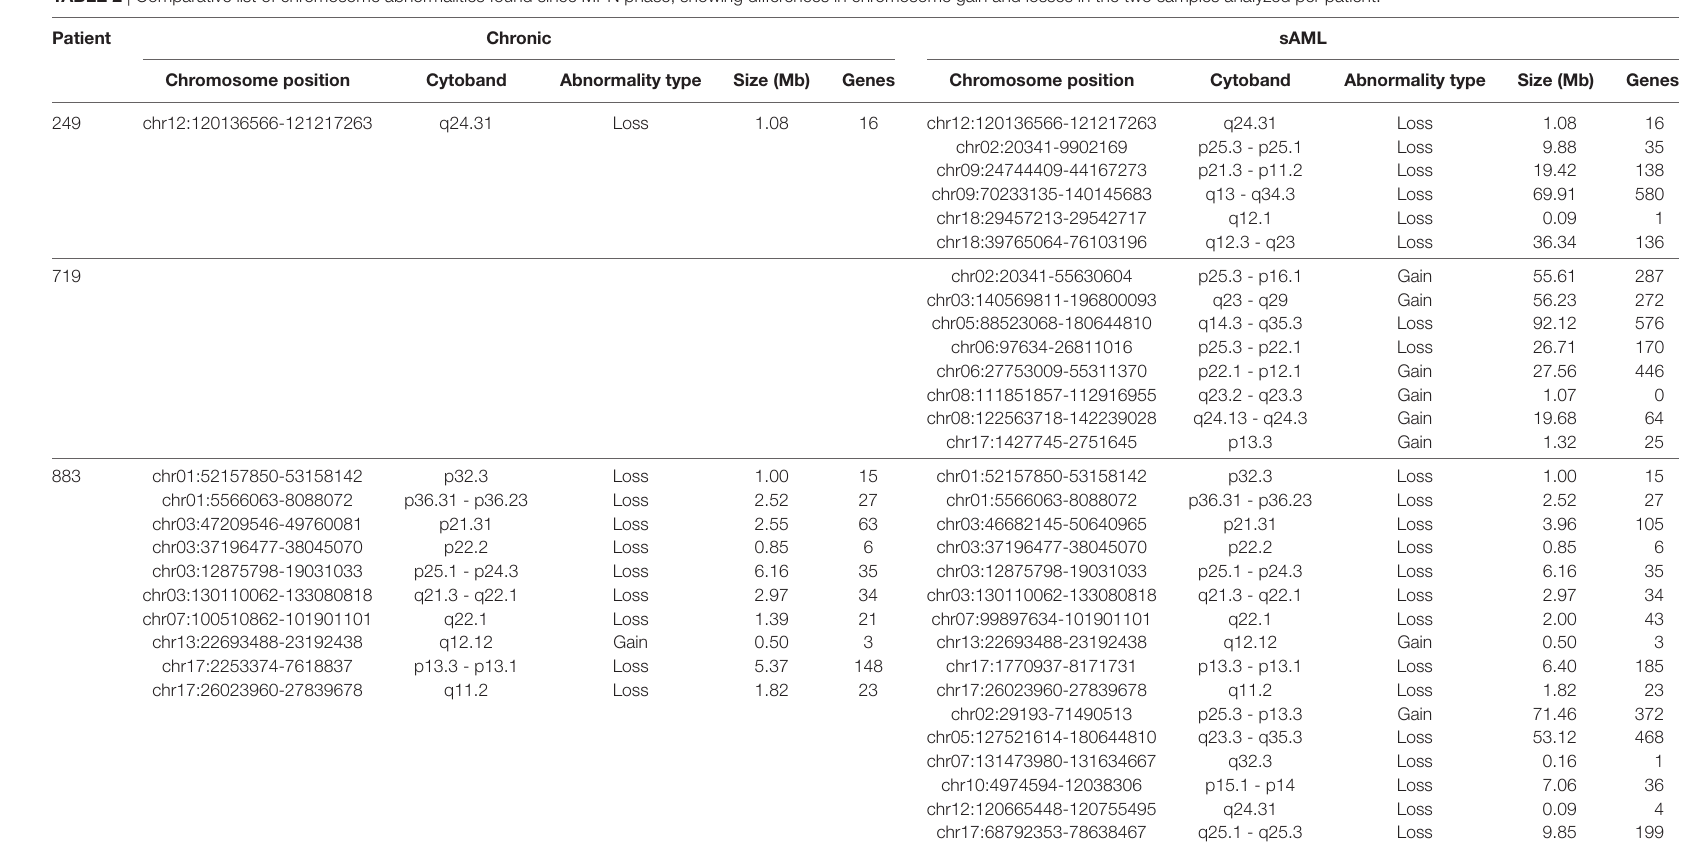
Table 2 | Comparative list of chromosome abnormalities found since MPN phase, showing differences in chromosome gain and losses in the two samples analyzed per patient.